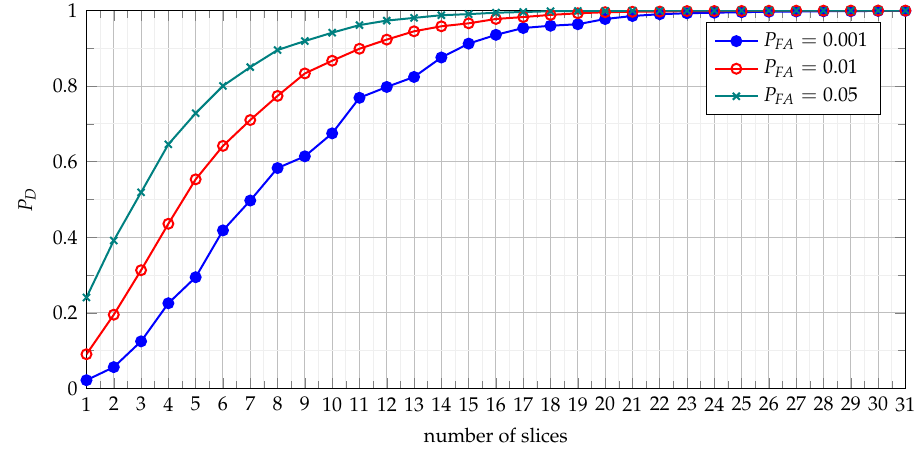
Figure 9. Dependence of the probability of detection on number of slices used in the TSCPF statistics for different P FA and SNR = 12 dB. −